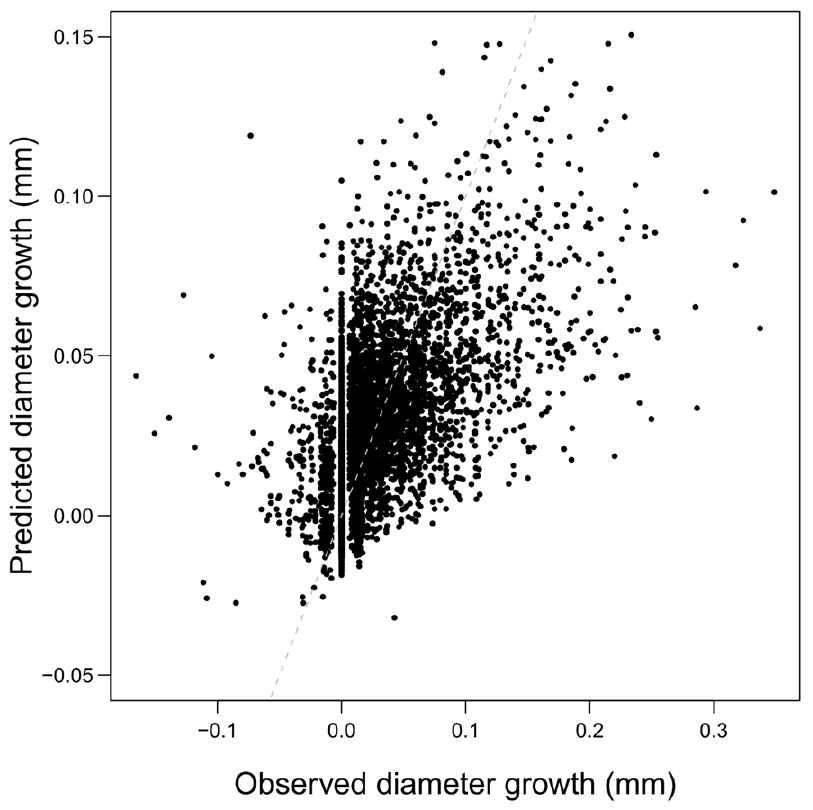
Figure 5. Predicted versus observed diameter growth under the model m BIC . The white dashed line is the identity line y = x . Note that the model overestimated the individual growth under 0.05 mm.d 2 1 and underestimated the growth above 0.1 mm.d 2 1 . doi:10.1371/journal.pone.0034074.g005 PLoS ONE |